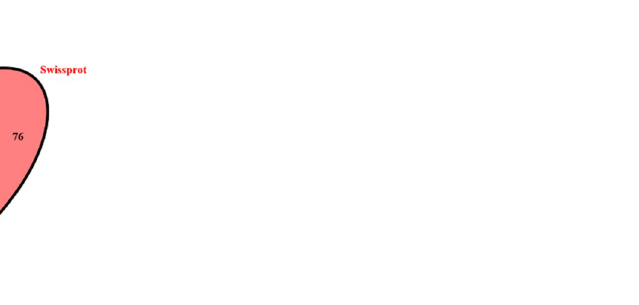
Figure 2. Venn diagram of annotation.